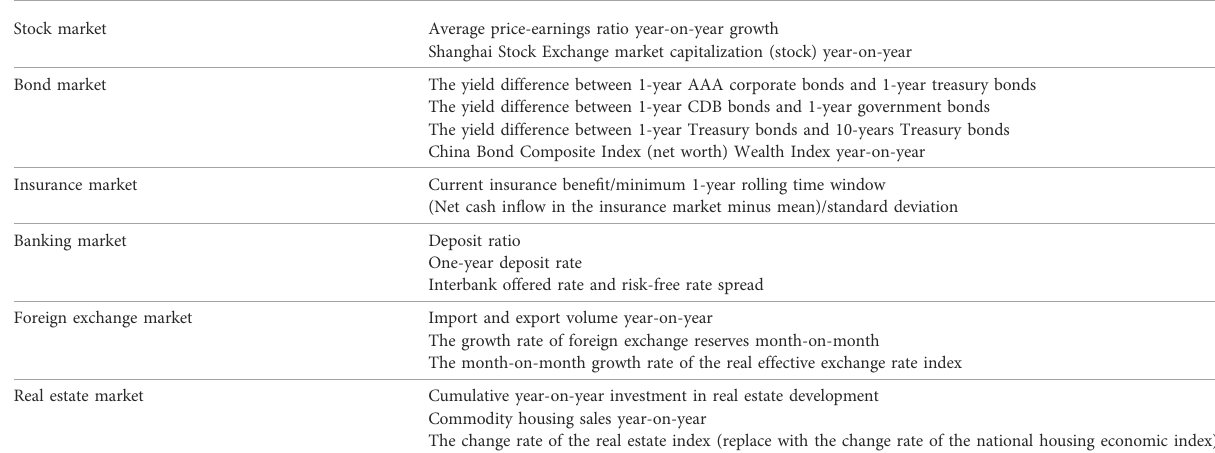
TABLE 1 FSI indicator system. Sub-market